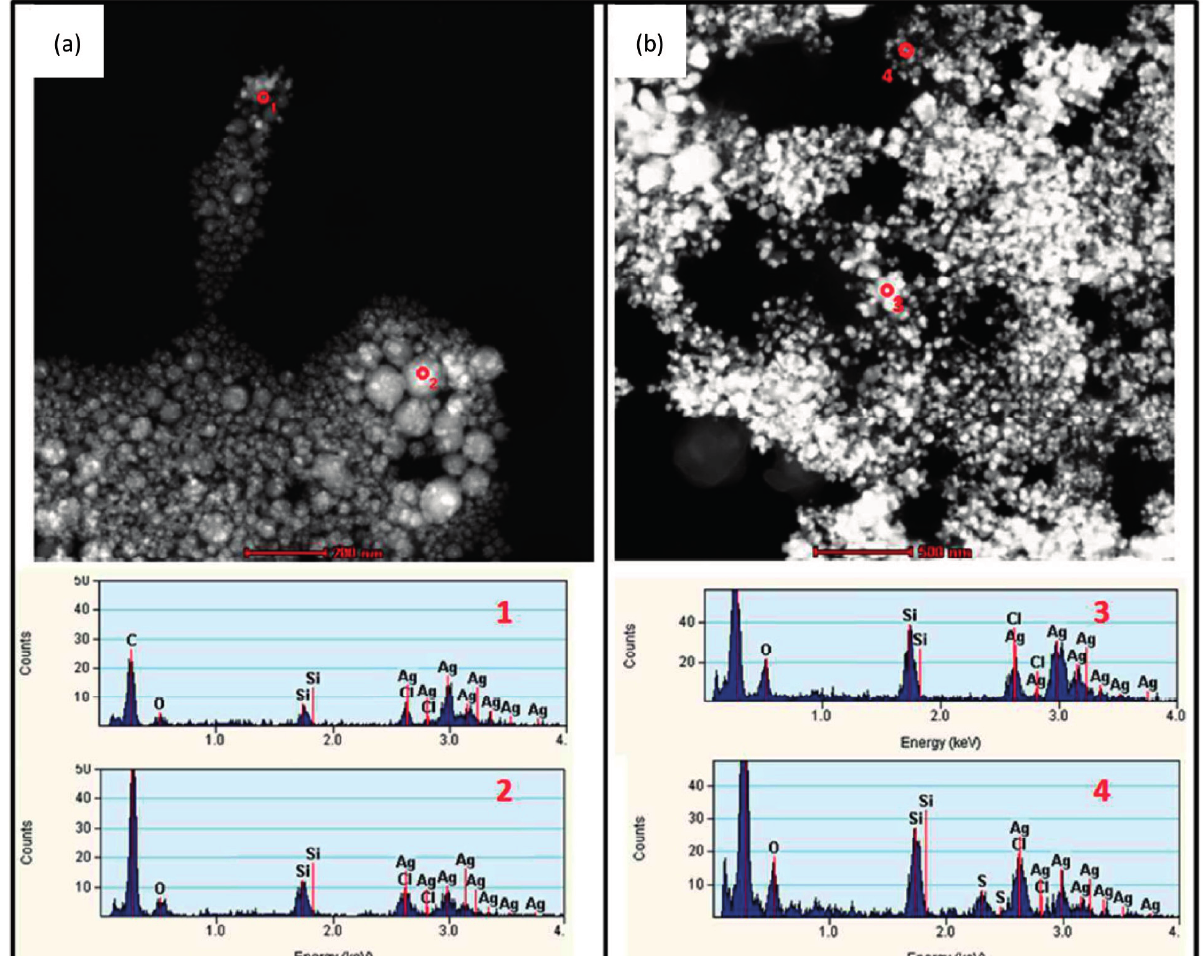
Figure 3. ( a , b ) HAADF-STEM-EDX characterization of the precipitates formed after the incubation of 17.0 µg/mL AgNO 3 (equal to an Ag concentration of 10 μ g/mL) in ( a ) RPMI-1640 and ( b ) DCCM-1 cell culture medium, at 37 °C for 0.5 h. The corresponding STEM-EDX spectra 1–4 were collected from the areas 1–4 marked in ( a , b ); The precipitates were collected by filtering the solution through 2 kDa filter membrane and were washed three times with DI-water. In both cell culture media, the particles have sizes that range from ~20 to ~200 nm. STEM-EDX analysis reveals that the precipitates in RPMI-1640 are probably a mixture of silver oxide and silver chloride. The insoluble compounds formed in DCCM-1 likely also contain silver sulphide; ( c ) Inductively coupled plasma optical emission spectroscopy (ICP-OES) analysis of solubilized silver concentrations of 17 μ g/mL AgNO 3 (equal to an Ag concentration of 10 μ g/mL) in deionized (DI) water, RPMI-1640, DMEM, and DCCM-1 solutions, incubated at 37 °C for 0.5 h ( n = 3). Although 100% of the free Ag + ions were detected in the AgNO 3 DI-water solution, the amount of solubilized silver in cell culture media was less than 0.5 μ g/mL after incubation. The dissolved Ag + ions are probably sequestered as insoluble precipitates in the cell media, indicating the limitation of using ICP-OES to study the kinetics of Ag + dissolution in cell culture media. Adapted with permission from [143]. Copyright 2013 American Chemical